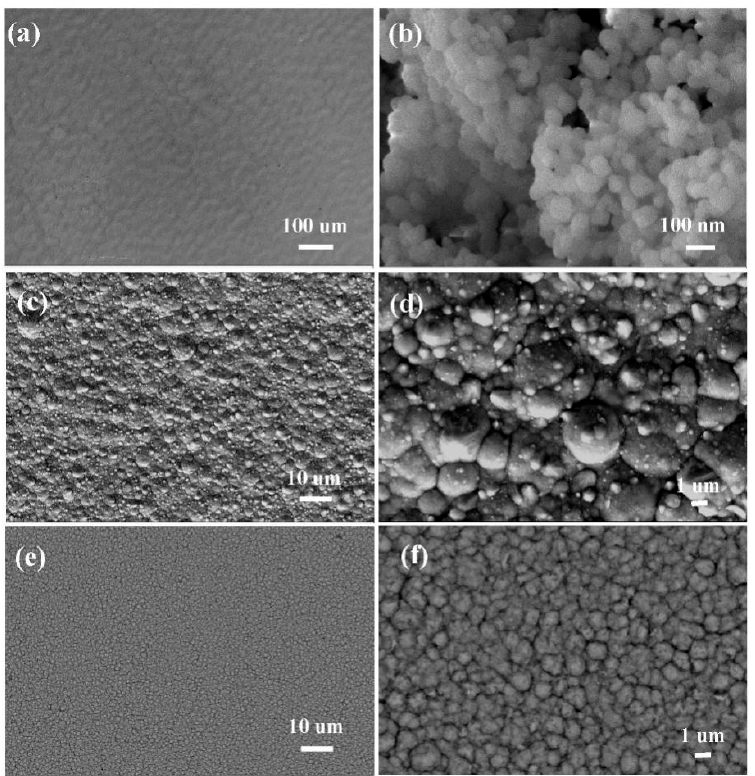
Table 4. Atomic percentage of each element in the coatings (wt %).